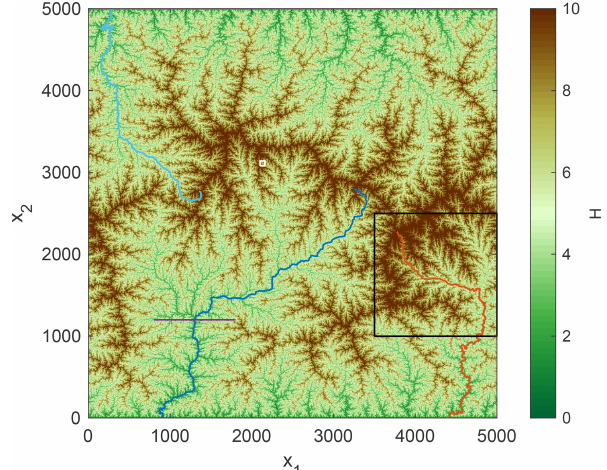
Figure 3. Fluvial equilibrium topography under uniform uplift (Hergarten, 2020, Fig. 1a). The small, white square depicts the do- main of Fig. 2 and the black square the domain of Figs. 10 and 12. The blue and red lines show the three biggest rivers. The violet line refers to the profile shown in Fig.